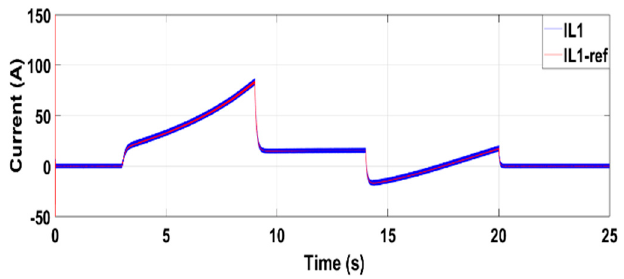
Figure 13. The v dc voltage and reference with EQZSI.